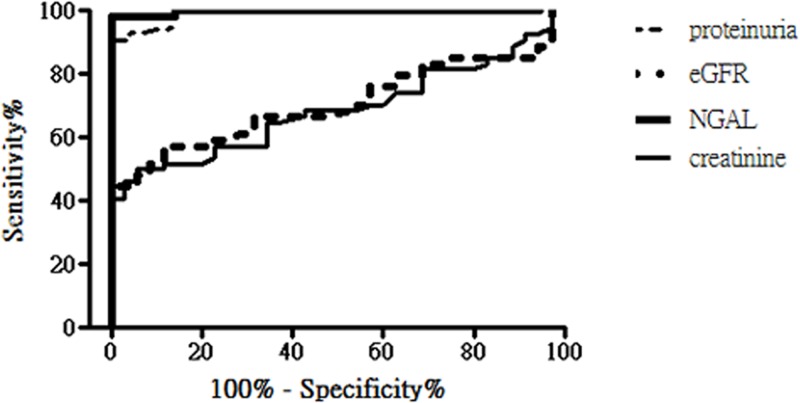
The area under the receiver operating characteristic (ROC) curves (AUC) constructed for uNGAL, proteinuria, eGFR and serum creatinine levels in predicting the presence of biopsy-proven lupus nephritis in patients with systemic lupus erythematosus.The AUC of uNGAL (solid line) was 0.99 (p < 0.0001). The AUC of proteinuria, eGFR and serum creatinine was 0.97 (p<0.0001), 0.71 (p = 0.0011) and 0.69 (p = 0.0028), respectively.